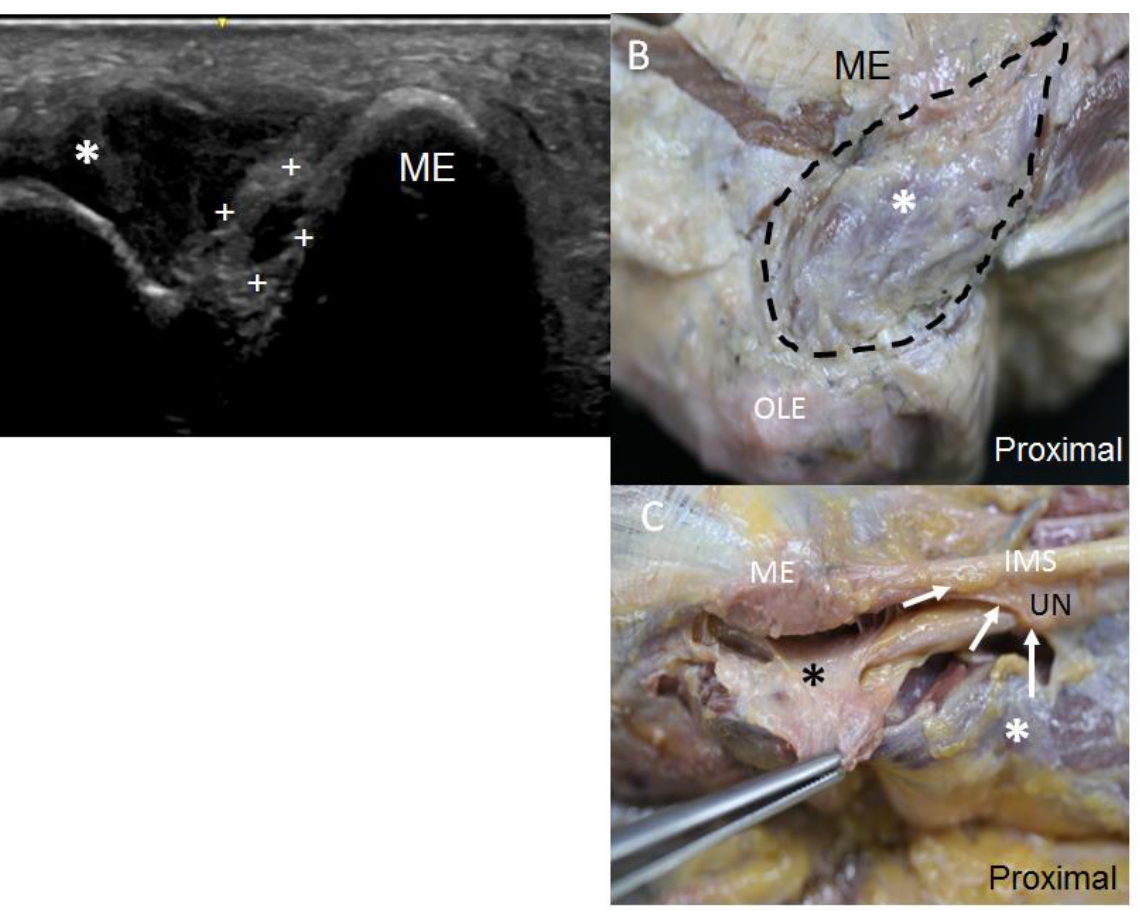
Figure 5. ( A ) Osteofibrous tunnel occupied by a muscular variant (white asterisk), which pressed the UN (white crosses) towards the medial wall of medial epicondyle (ME). It is shown that the UN appears as an oval anechoic structure, as it has lost its internal fascicular morphology. ( B ) Anatomical view of the muscular variant in the elbow delimited by intermittent black line. It is shown that it originated from the medial aspect of the olecranon (Olc) and is inserted into the medial epicondyle (ME). ( C ) The UN at the osteofibrous tunnel is included in the epimysium of this muscular variant (black asterisk), which was dissected from its multiple insertions. A white asterisk marks the medial head of triceps brachii. Finally, it is shown that the UN, before entering the osteofibrous tunnel of the elbow, crosses beneath an aponeurotic arch (white arrows) formed by the extension of connective tissue that covers the triceps brachii and is inserted into the intramuscular septum